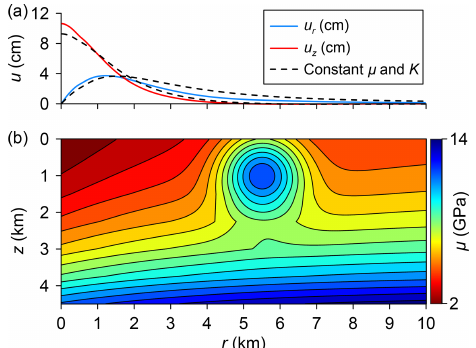
Figure 10. Distributions of u r and u z at z = 0km and t = 20 months (a) and shear modulus (b)